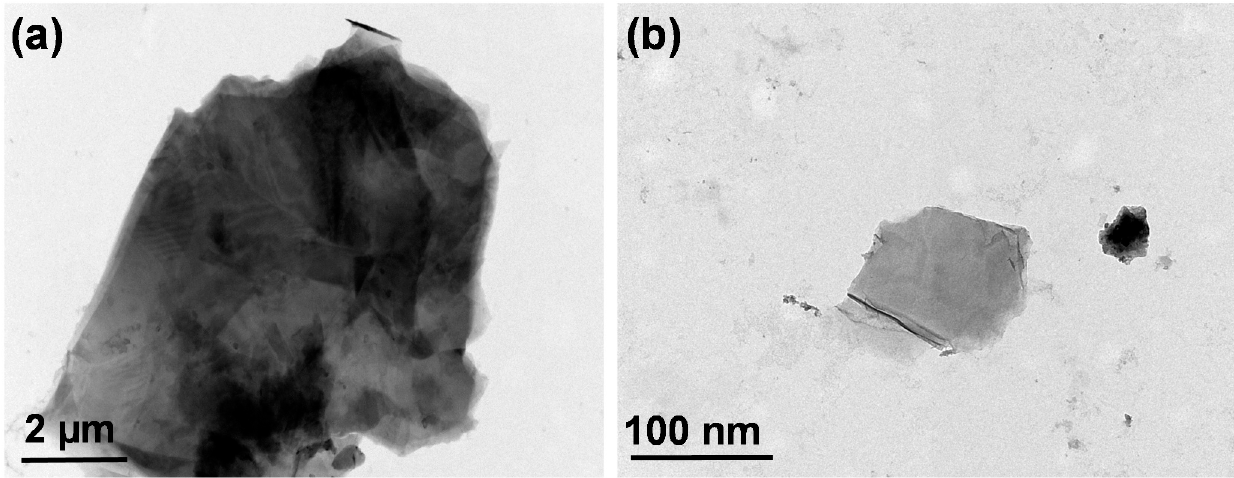
Figure 2. Transmission electron microscopy images of ( a ) graphite and ( b ) graphene